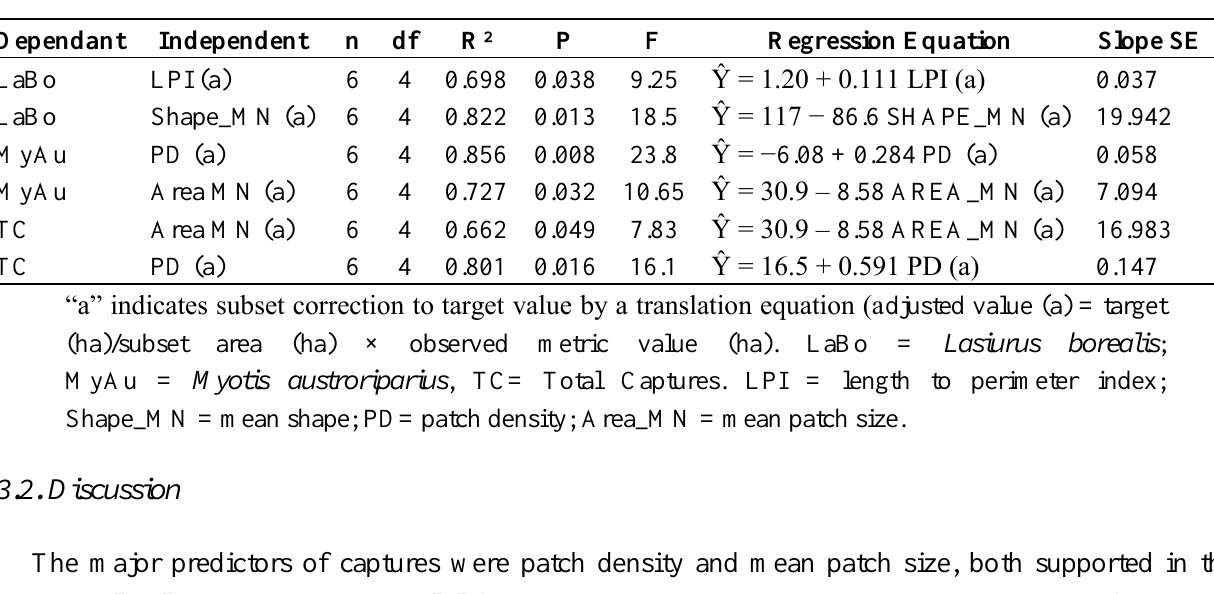
Table 3. Simple regression probability (p), and R² values for fragmentation metrics generated from a GIS analysis of six wildlife management areas and their surrounding landscapes in the northeastern Arkansas region. To save space, only those tests whose p values less than 0.05 are reported